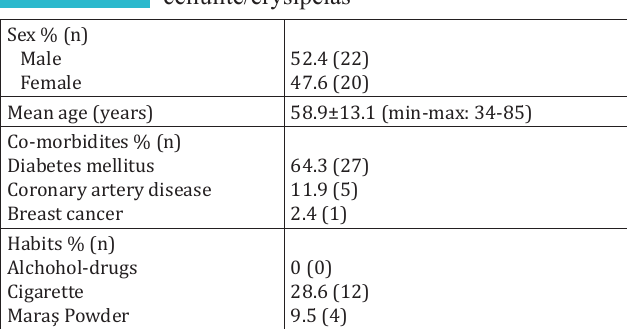
Demographic features of patients with